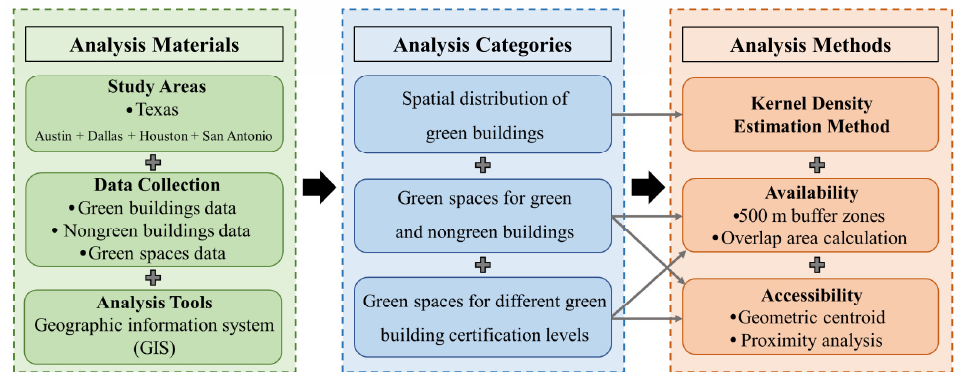
Figure 4. The flowchart of